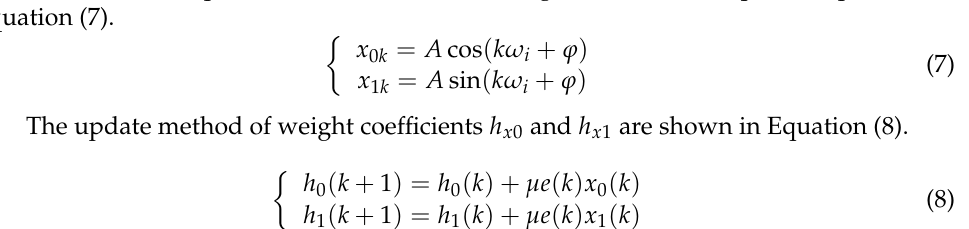
Table 1. The meaning of the characters. Characters N The number of the AMI frequency ω i The i-th value of the AMI angular frequency k ω i The discrete-time k when ω i appears A x , A y and A z The amplitude of the AMI on the x , y , z -axes ϕ x , ϕ y and ϕ z The phase of the AMI on the x , y , z -axes x 0 and x 1 A set of orthogonal functions for estimating AMI h 0 and h 1 The weight coefficient of the x 0 ( k ) and x 1 ( k ) ˆ N ˆ N ˆ N x y and z The estimated triaxial AMI at discrete time k e kx , e ky and e kz Residual error (MSE) after notch filter B x , B y and B z The magnetic field after notch